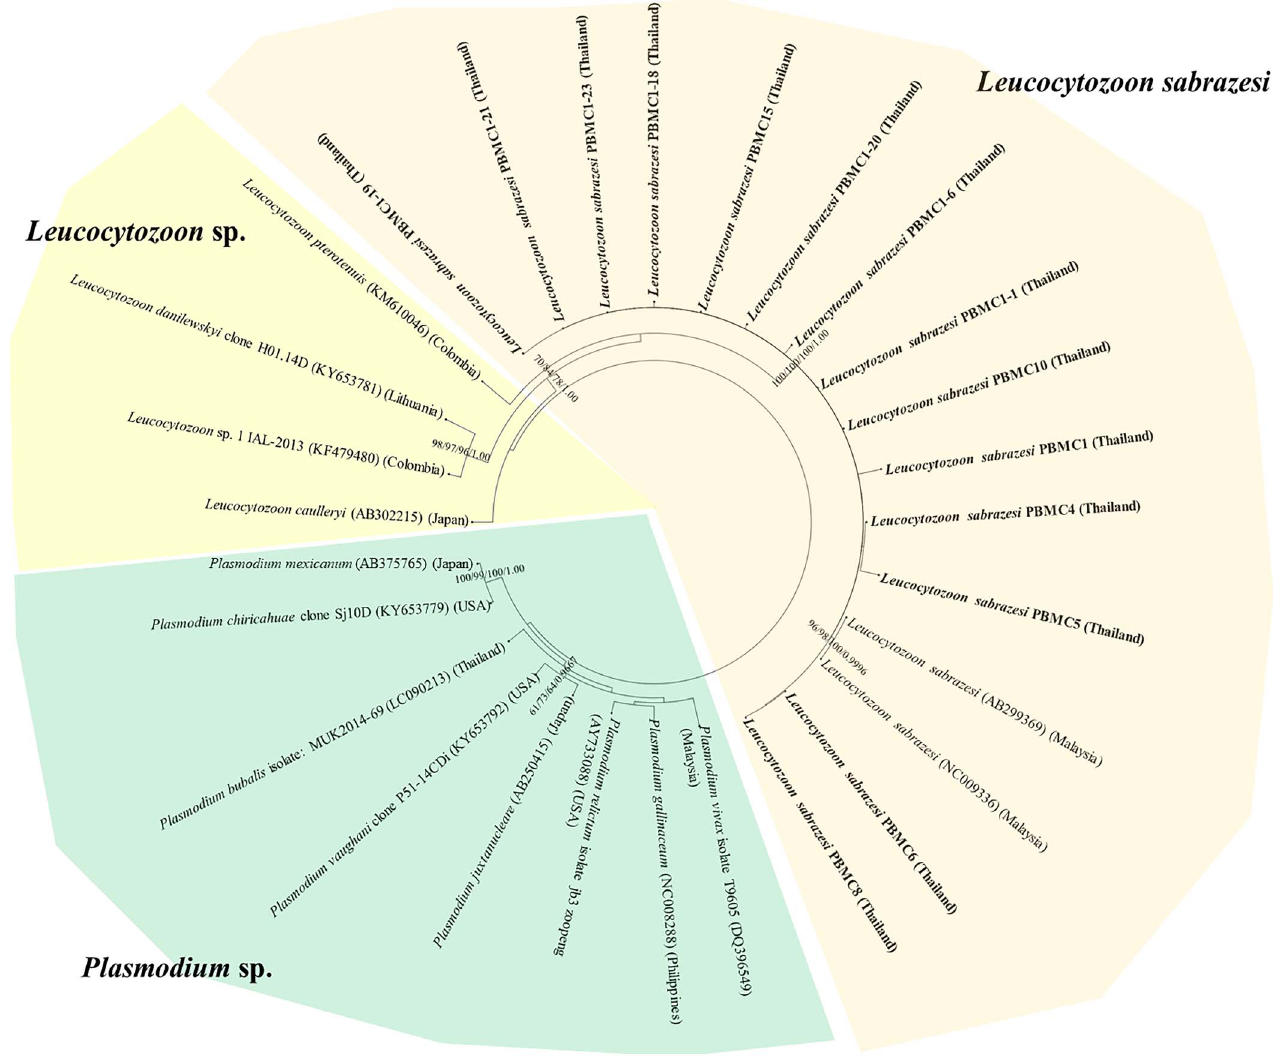
Fig. 4. Phylogenetic tree of the concatenated gene sequences in this study (bold face) and those obtained from GenBank. The boostrap values calculated from NJ, ML, MP and BA are labeled on each